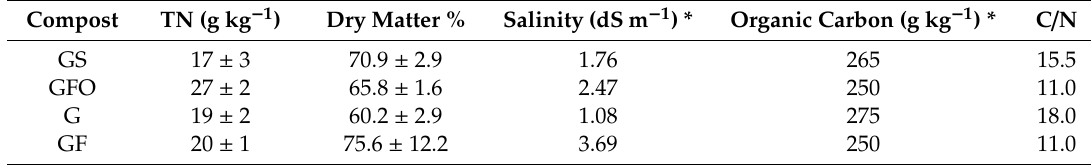
Table 3. Main chemical-physical characteristics of the compost types used in the